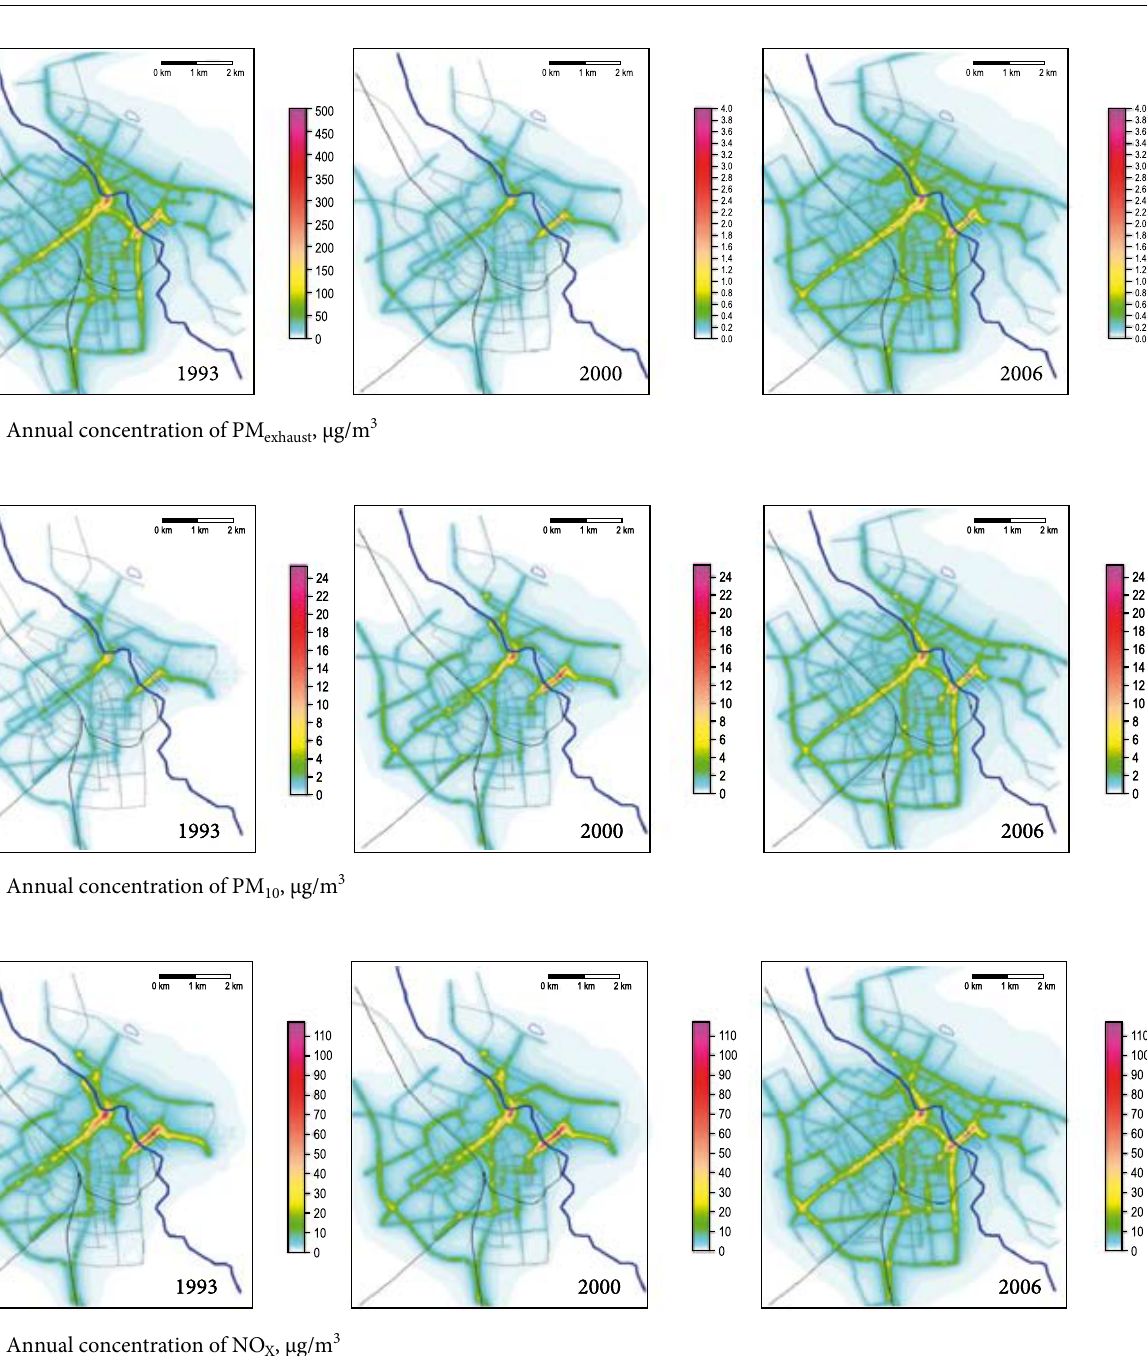
fig. 5. Annual concentration of NO X , μg/m